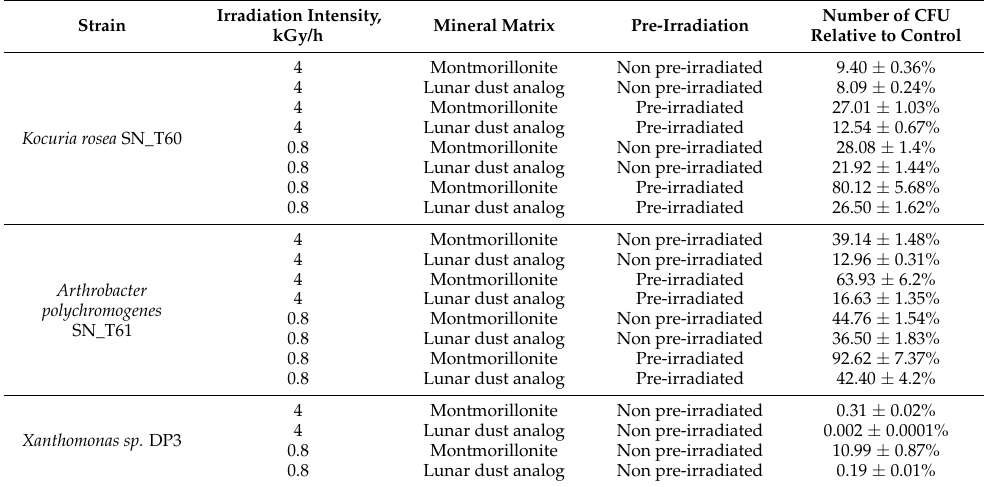
Table A1. Dependence of bacterial radioresistance on irradiation